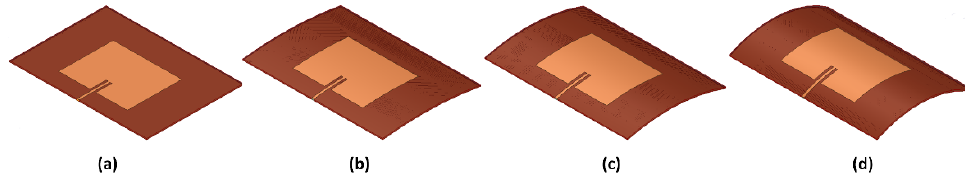
Figure 3. Antenna curved on the cylindrical surface with different E-plane bending angles: ( a ) 0°, ( b ) 10°, ( c ) 20°, and ( d ) 35°.